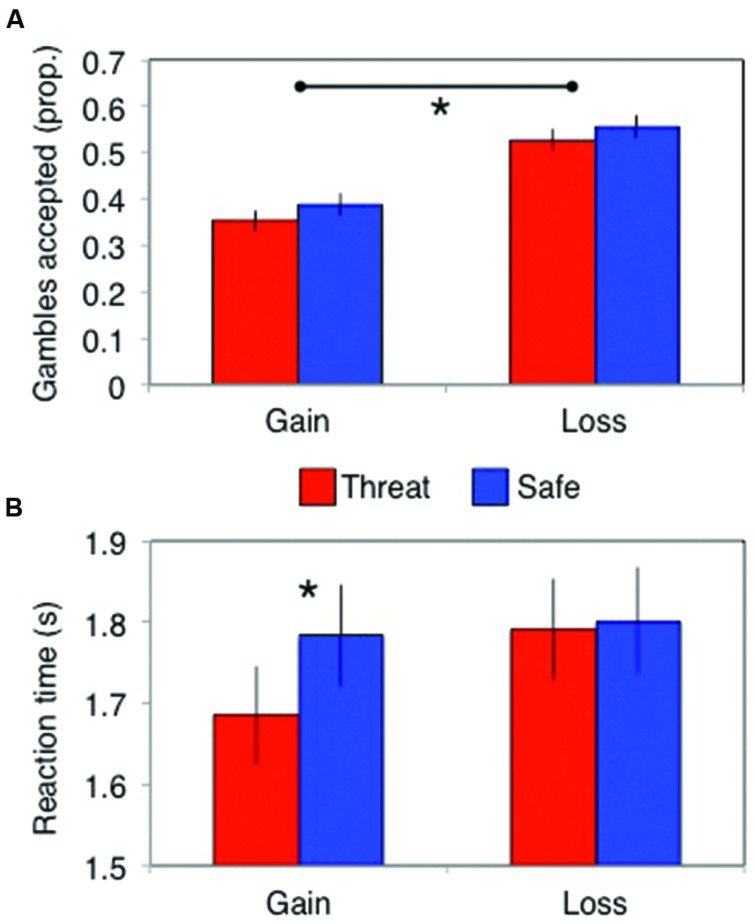
(A) The framing effect did not differ between stress conditions in terms of the proportion of gambles accepted, but (B) stress did speed up responses (in seconds) in the gains domain. Error bars indicate SEM; *p < 0.01.